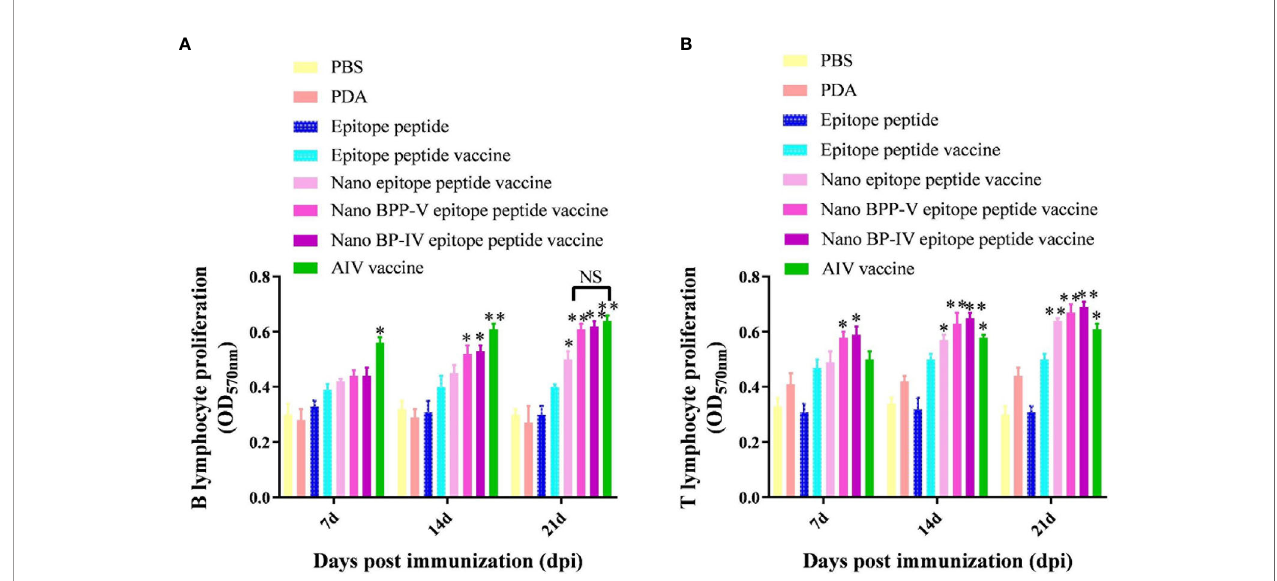
FIGURE 6 | The nano BPP-V and BP-IV epitope peptide vaccines promoted the proliferation of splenic lymphocytes in immunized mice. The spleens of mice were collected on days 7, 14 and 21 after the fi rst immunization (n = 5), and B lymphocyte (A) and T lymphocyte (B) proliferation activity were detected by the MTT method. The epitope peptide vaccine group was used as a control group, * P < 0.05; ** P < 0.01. NS indicates no signi fi cant